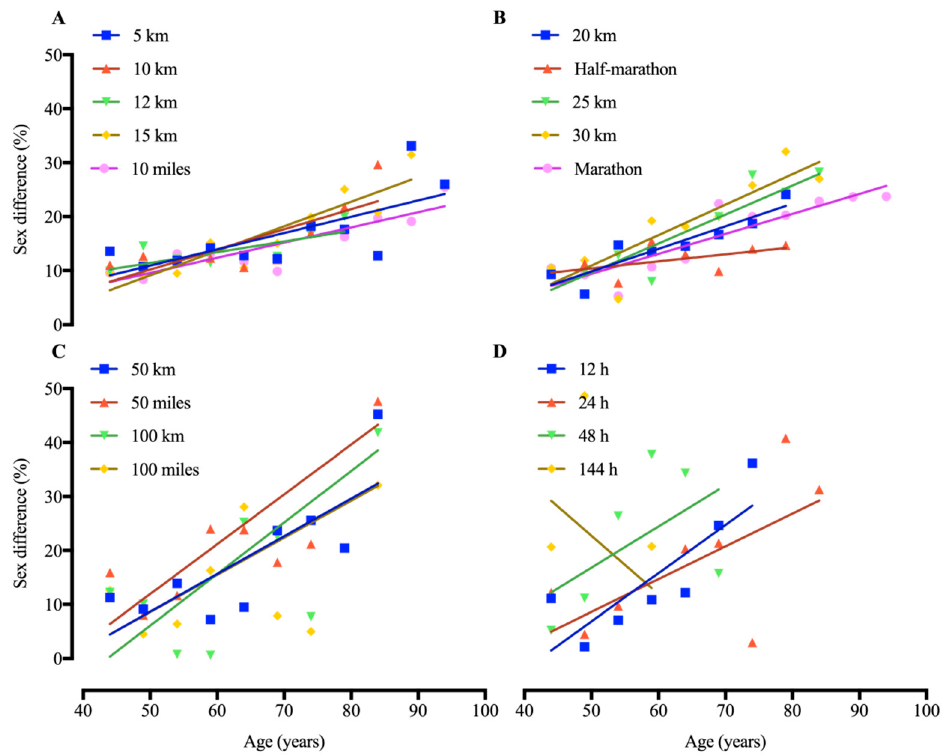
Figure 2. Linear regression between performance sex di ff erence (%) and age in American masters road running records. With the positive slopes, higher the age, higher the sex di ff erence (%) in each event. ( A ) events 5 km to 10 miles; ( B ) 20 km to Marathon; ( C ) 50 km to 100 miles; ( D ) 12 to 144 h. Dispersion data of ‘performance sex di ff erence ratio’ vs. ‘event length’ was plotted in Figure